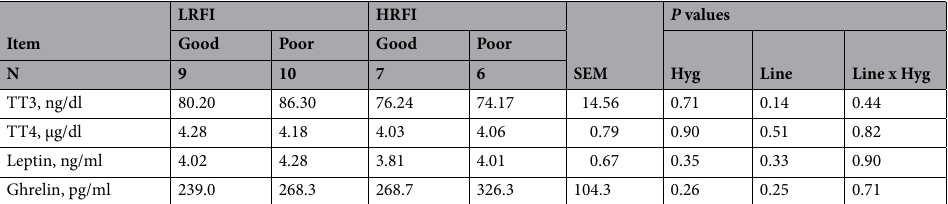
Table 1. Plasma hormone concentrations of pigs divergently selected for low (LRFI) or high (HRFI) residual feed intake and raised in good or poor hygiene conditions (Hyg). Plasma total triiodothyronine (TT3) and total thyroxin (TT4) concentrations were determined using commercial immunoassays. Plasma concentrations of leptin and ghrelin were quantified using radioimmunoassay. Values are LS means.